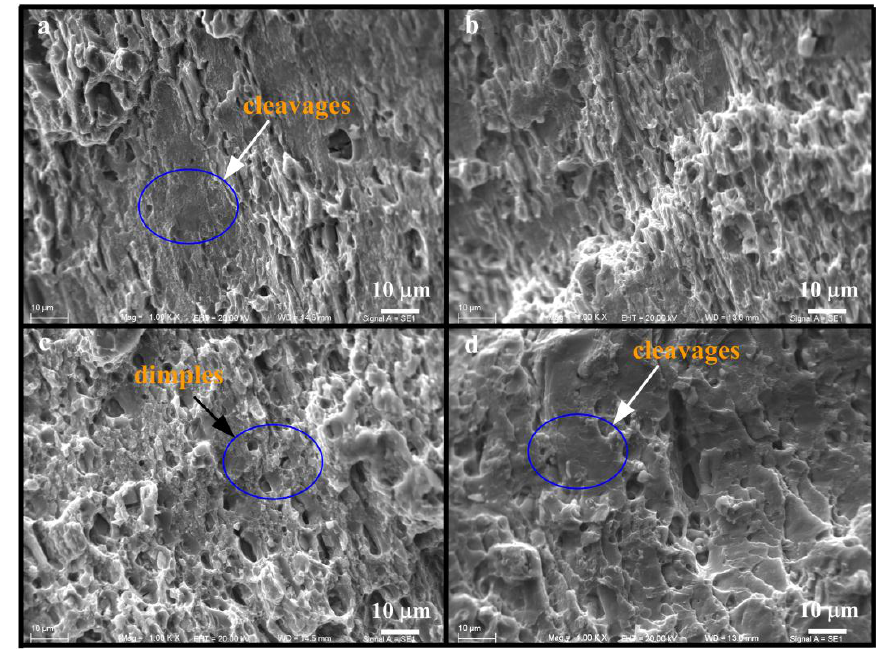
Figure 11. The SEM fracture morphology of 7075 T6 alloy without and with different contents of Sr: ( a ) 0 wt. % ; ( b ) 0.05 wt. %; ( c ) 0.1 wt. %; and ( d ) 0.2 wt. % Sr.